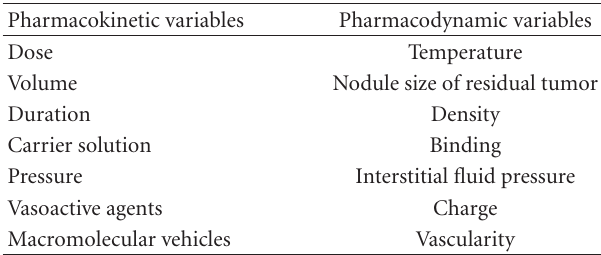
Table 2: Pharmacokinetic and pharmacodynamic variables in- volved in the administration of perioperative cancer chemotherapy in peritoneal surface malignancy